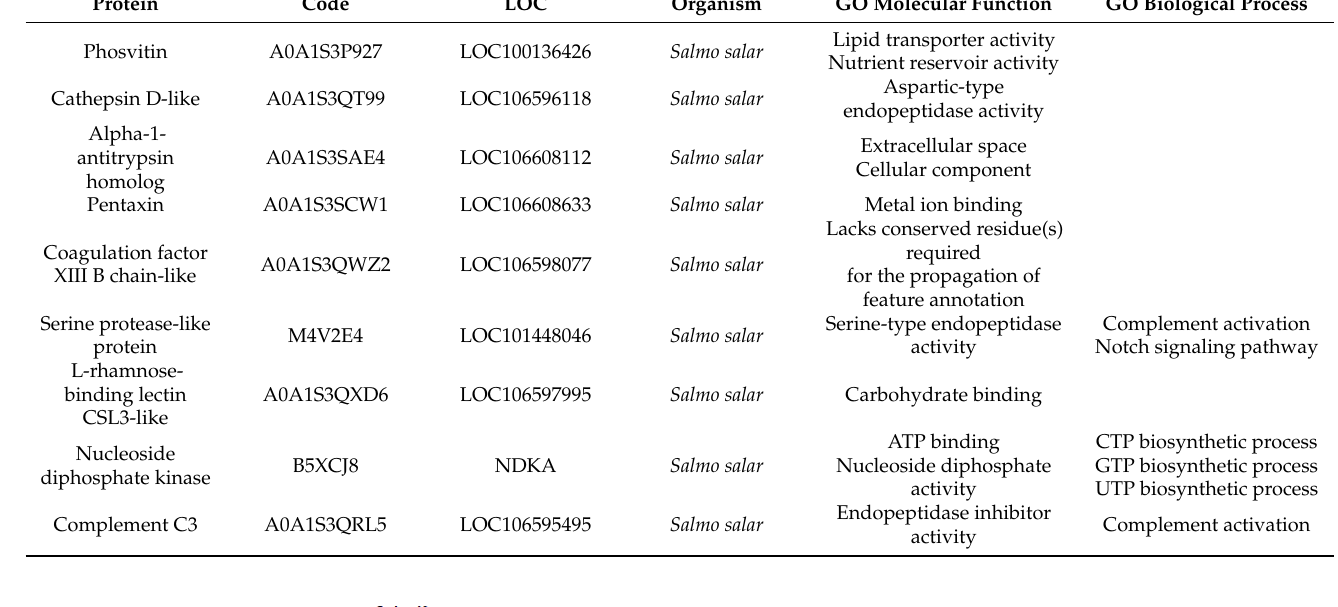
Table 4. List of selected / most significant proteins.